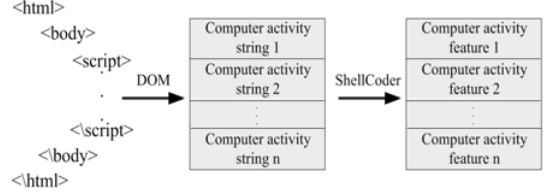
Fig. 2. The antigen feature calculation